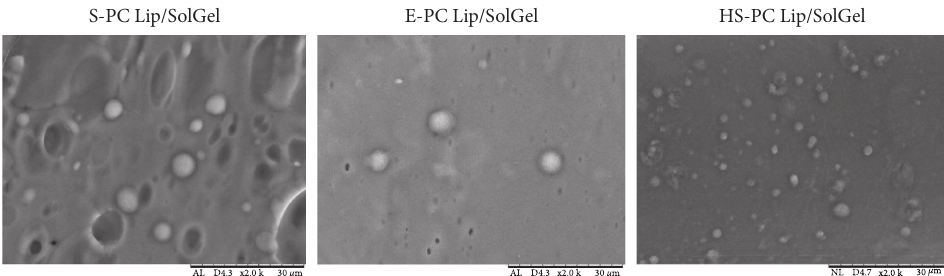
Figure 1: Morphology of the CUR-loaded liposomal solid gels obtained by SEM at a magnification level of 2.000x. S-PC Lip/SolGel, soy- phosphatidylcholine liposomal solid gel; E-PC Lip/SolGel, egg-phosphatidylcholine liposomal solid gel; HS-PC Lip/SolGel, hydrogenated- soy-phosphatidylcholine liposomal solid gel.